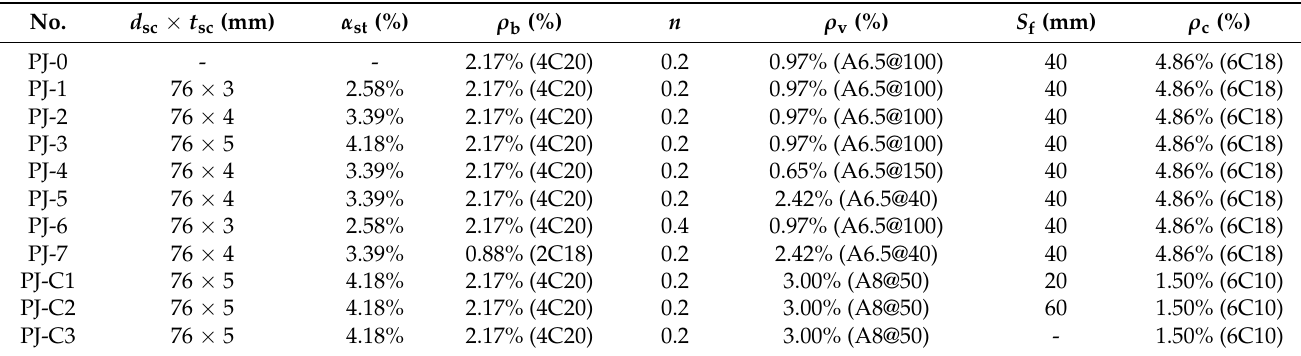
Figure 1. The overall appearance and detailed reinforcements of the specimens. A total of ten RC beam to PFCC column exterior joints with STC and one reference joint were manufactured. The design principle of “strong members, weak joint” was adopted because the main purposes of this experiment was to investigate the failure modes and seismic behavior of the composite joints. The impacts of the steel ratio of STC α st , reinforcement ratio of the frame beam ρ b , axial compression ratio n , stirrup ratio of the joint ρ v and CFRP strips spacing s f are considered. The detailed parameters are depicted in Table 1. Table 1. The detailed parameters of the specimens.